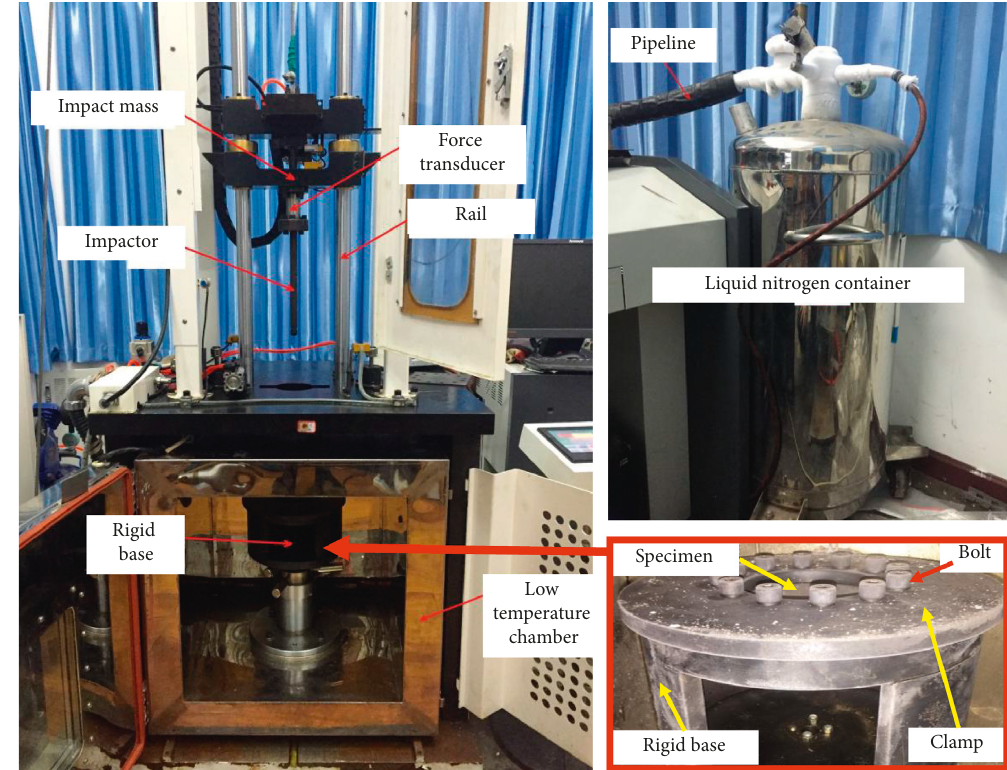
Figure 7: The drop hammer impact test machine.